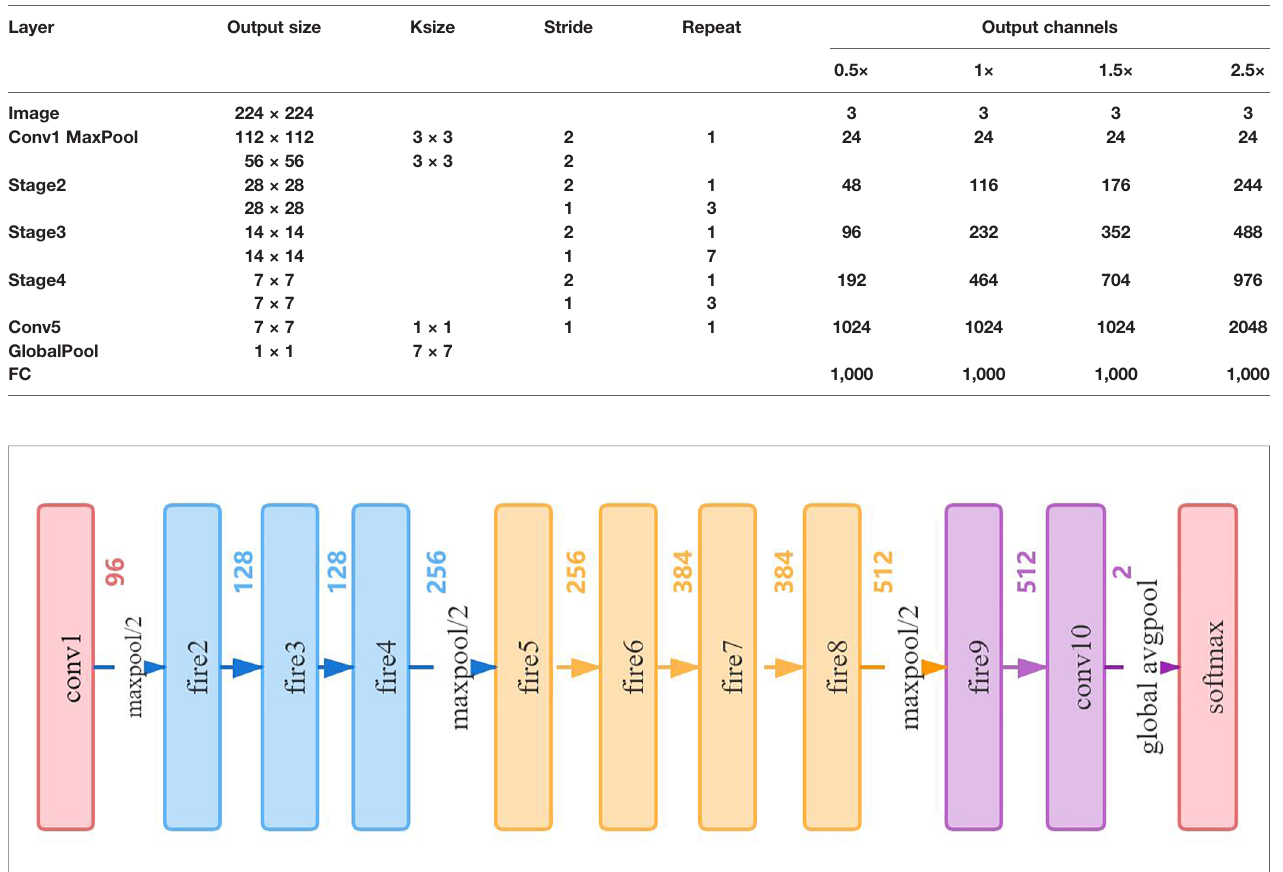
TABLE 2 | Overall architecture of Shuf fl eNetv2.